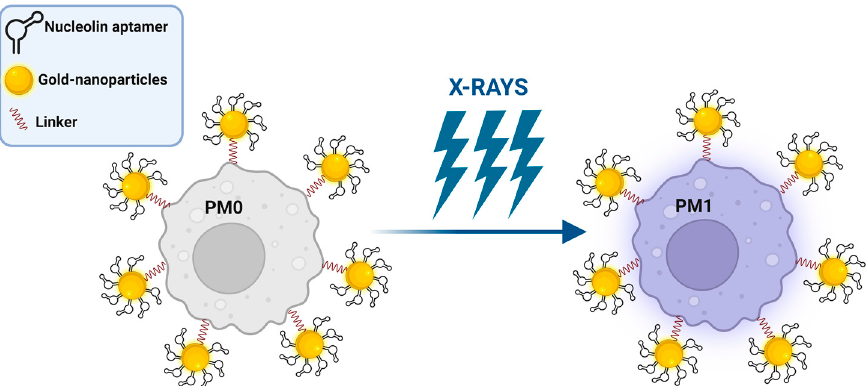
Figure 6. Schematic representation of PSA macrophage engineering strategy (see text for details). Created with BioRender.com (accessed on 2 March 2023)